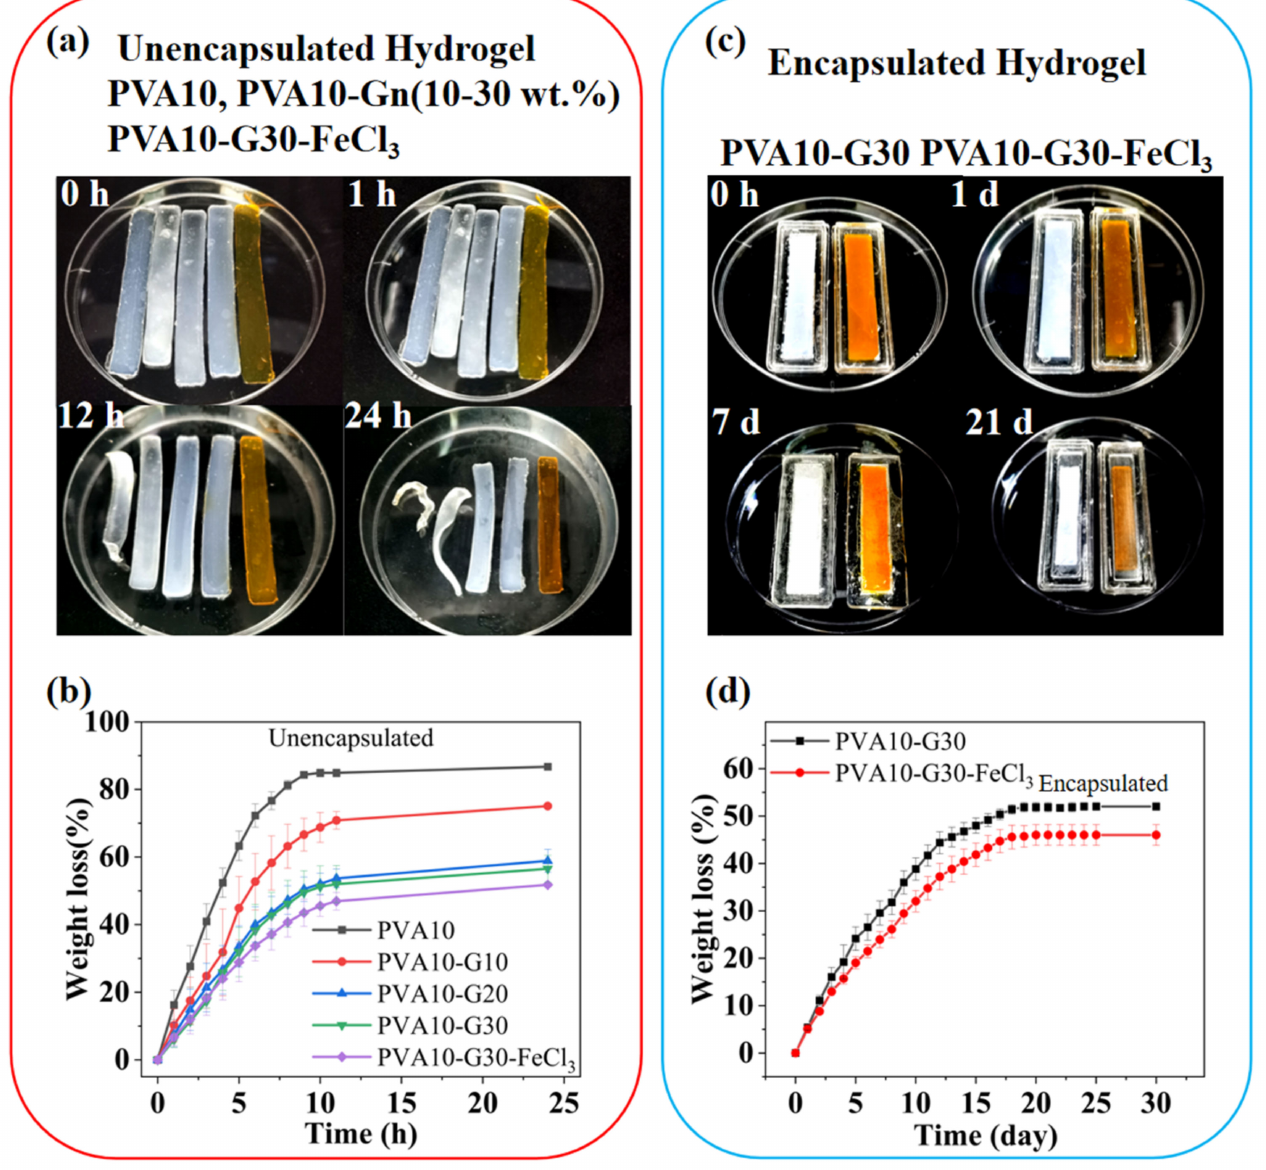
Figure 2. ( a ) Comparison of PVA10, PVA10-Gn, and PVA10-G30-FeCl 3 hydrogels exposed in the air at the beginning, after an hour, after half a day, and after a day. ( b ) Weight change of the PVA10, PVA10-Gn, and PVA10-G30-FeCl 3 hydrogels as a function of time. ( c ) Comparison of PDMS- encapsulated PVA10-G30 and PVA10-G30-FeCl 3 hydrogels exposed in the air at the beginning, after a day, after 7 days, and after 21 days. ( d ) Weight change of the PDMS-encapsulated PVA10-G30 and PVA10-G30-FeCl 3 hydrogels as a function of